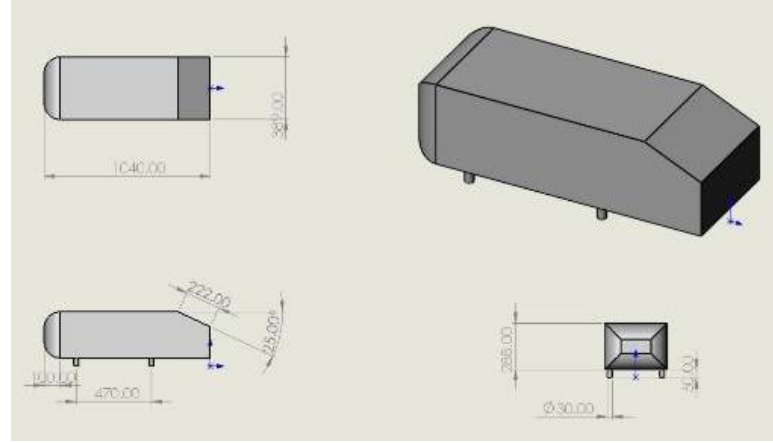
Figure 6. Three-dimensional model of Ahmed Body in SolidWorks with a slant angle of 25°. The boundary conditions of the model are as listed in Table 1: